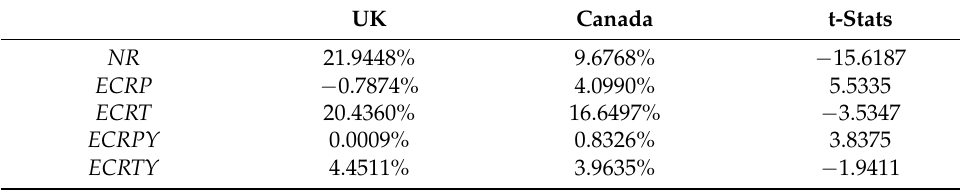
Table 5. The two-sample mean difference t